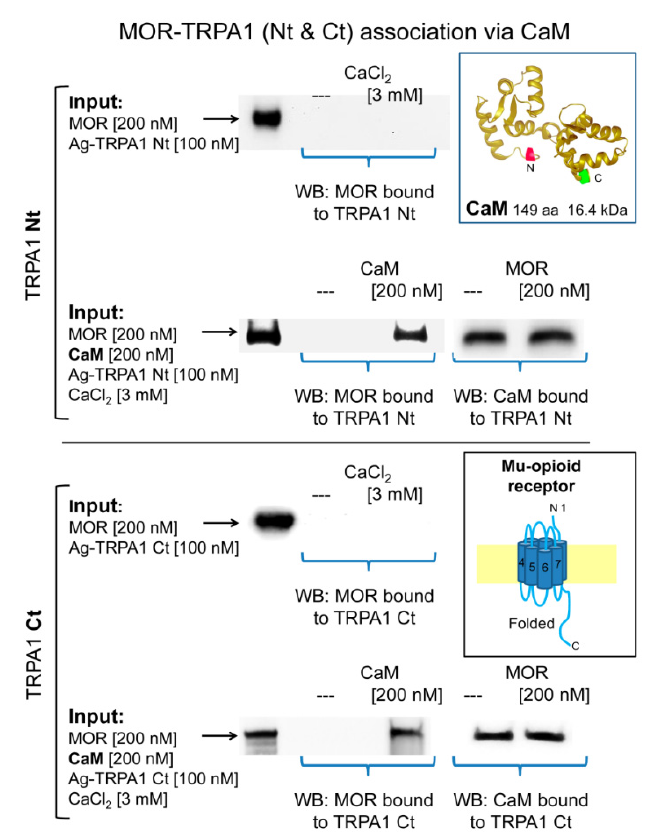
Figure 5. Calmodulin mediates the association of TRPA1 with MORs. The recombinant cytosolic Nt and Ct regions of TRPA1 were covalently attached to N -Hydroxysuccinimide (NHS)-agarose beads and then incubated with MOR in the absence and presence of 3 mM CaCl 2 . In another set of assays, the TRPA1 regions were sequentially incubated with calmodulin (CaM) and MORs in the presence of 3 mM CaCl 2 . At the end of the incubation, agarose-TRPA1 was recovered by several cycles of washing-resuspension and the bound proteins were detached with 2× Laemmli buffer and resolved by SDS-PAGE followed by immunodetection. Further details in the Methods. Key: Input, Proteins incubated with agarose TRPA1, MORs are immunodetected; WB, immunodetected protein in Western blot.